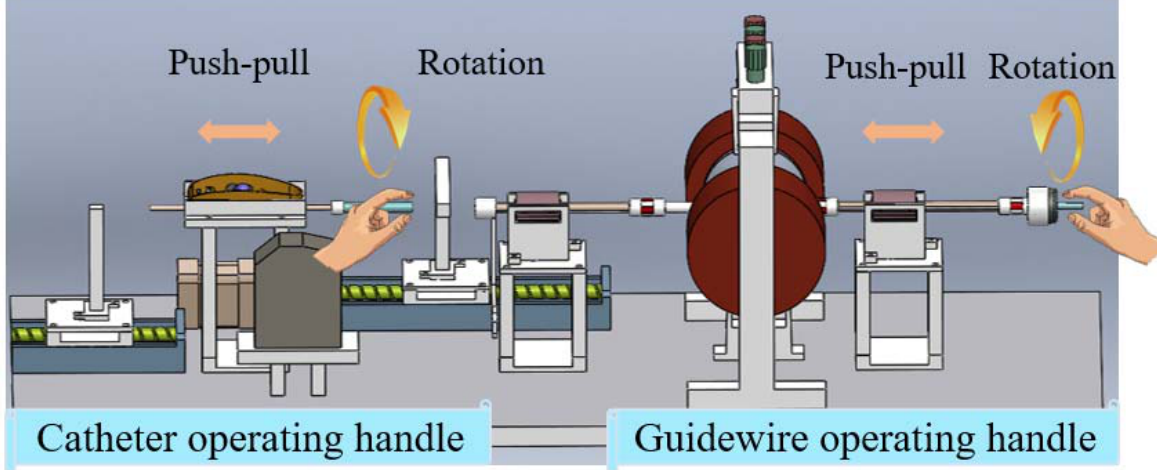
Figure 9. The collaborative operation mechanism of the designed master haptic device.